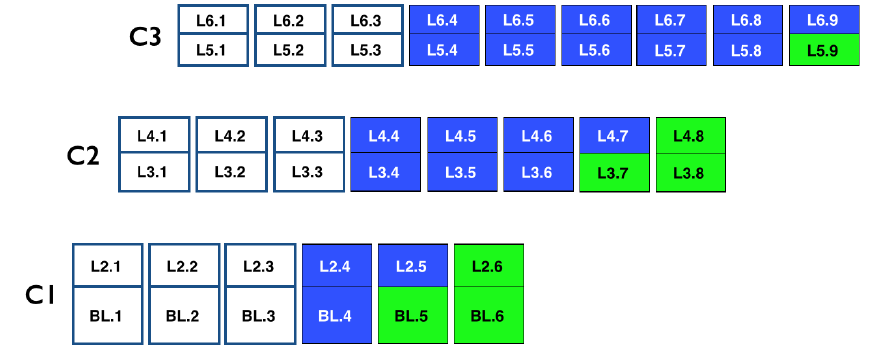
Figure 6. ALD streaming classes using the ICC class composition option—C1 denotes class one, C2 denotes class two and C3 denotes class three.